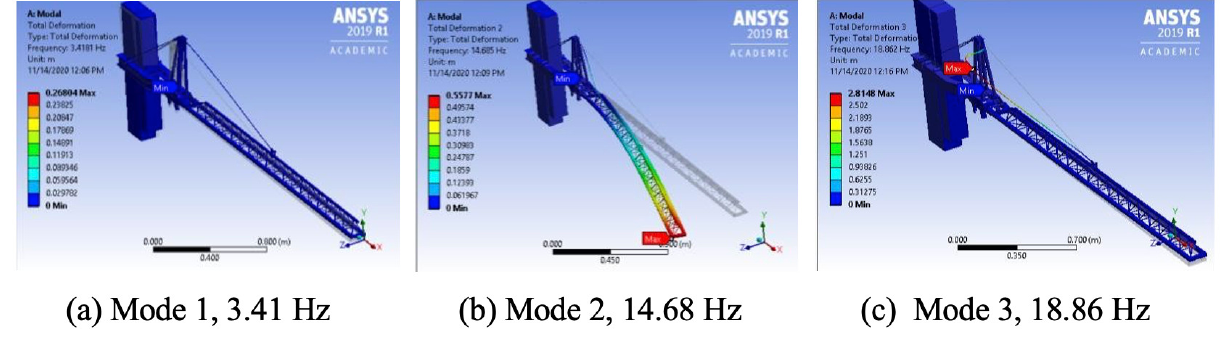
Figure 6. Modal parameters of the boom of occurrences, which generally happens in symmetrical structures. Mode 3 illustrated a bending effect in boom and a metallic cable at a natural frequency of 12.22 Hz. Figure 9 confirmed marginal differences in the first three natural frequencies of the mast and the tower crane with the first BC-1. This is a sign of probable tuning of natural frequencies between the mast and the tower crane, though the latter is on a higher